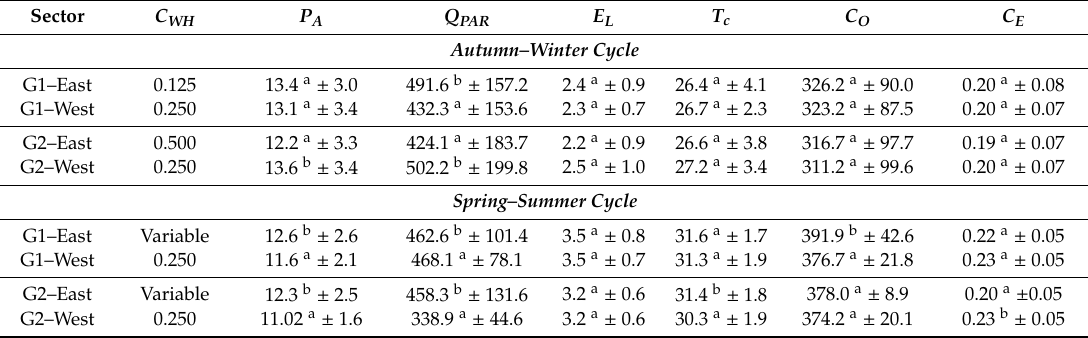
Table 6. Average values ( ± standard deviation) of parameters measured in the plant leaves for di ff erent whitening concentration C WH (kg L − 1 ): Photosynthetic rate P A ( µ mol CO 2 m − 2 s − 1 ), PAR incident